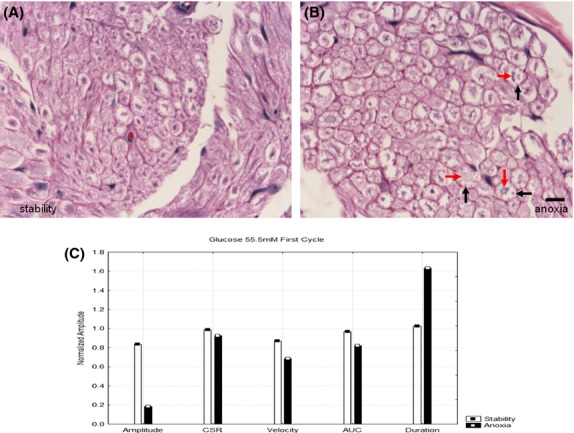
Hematoxylin and eosin stained nerve cross-sections at 60×. (A) Nerve maintained in fully oxygenated state at 37°C throughout the experiment with 55 mmol/L glucose in the perfusate. There is mild axonal swelling. (B) A second nerve exposed to five cycles of anoxia showing disruption of myelin (black arrow), with a relative preservation of axonal structure (red arrow) amid moderate axonal swelling. A notable correlation can be drawn between the cytomorphological effects (i.e. myelin disruption) seen here and that seen ultrastructurally under the same treatment conditions. The line at the bottom of the image represents 10 microns. (C) Neurophysiological results in these same two nerves after the a single cycle of anoxia. There were no responses in the nerves subjected to anoxia after the first cycle. The nerve subject to anoxia had significantly lower NAP amplitude, velocity, and area under the curve with increased durations.